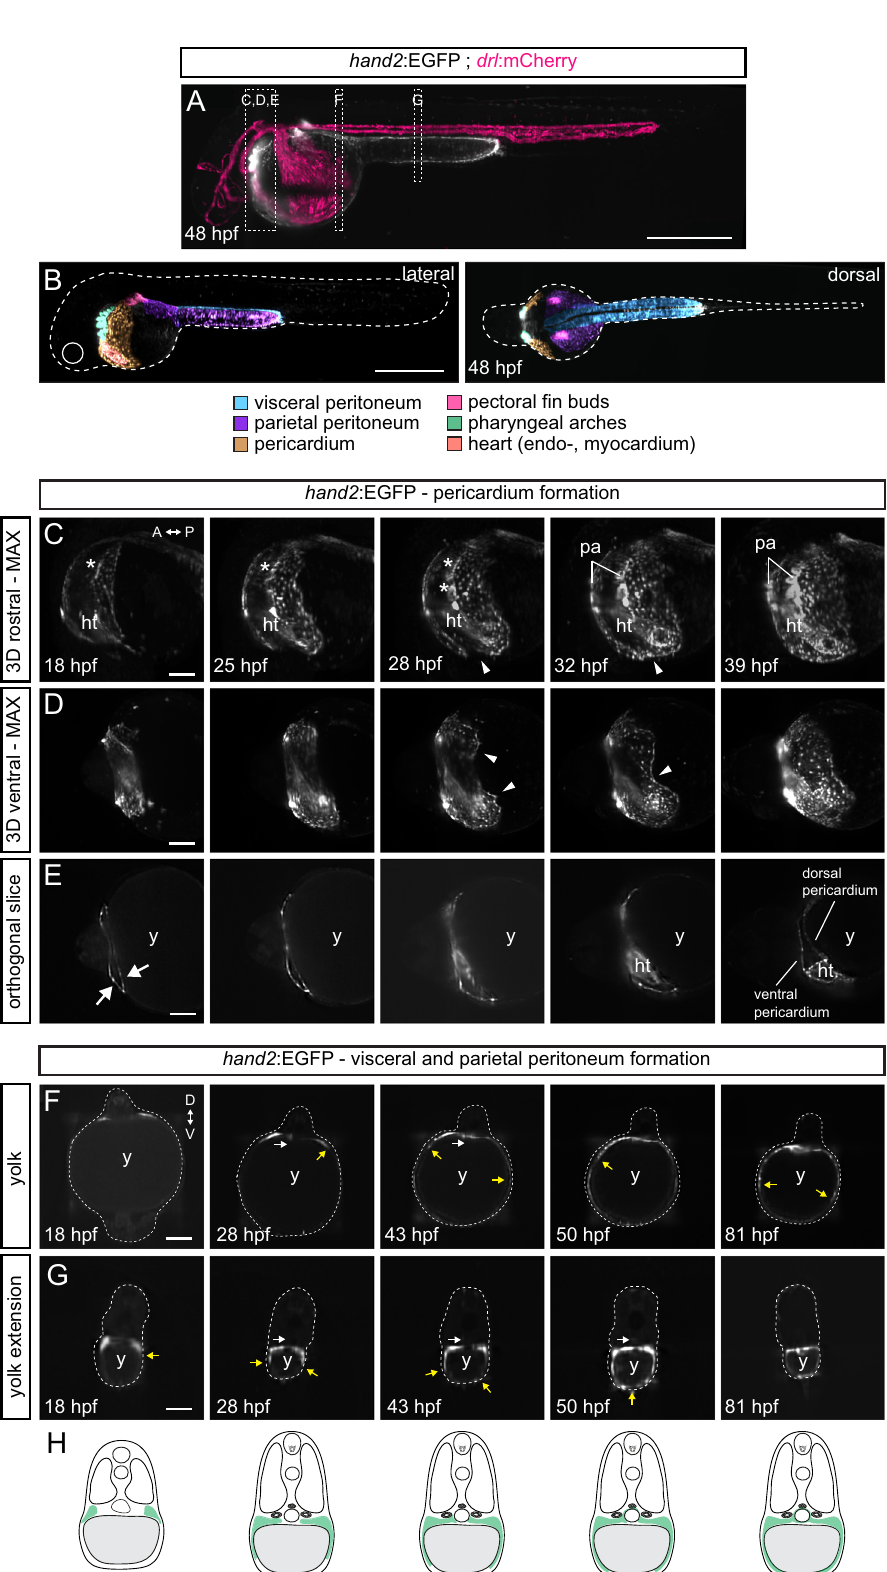
labeled cells and hand2: EGFP-expressing cells lining the body wall, respectively, indicating that also the ventral migration of the parietal peritoneum progenitors is perturbed in hand2 mutants (Fig. 6C, F, G – J and Supplementary Fig. 8 and Supplementary Movie 4). Consequently, han S6 -homozygous embryos also fail to form a proper body wall, likely resulting in herniation of the